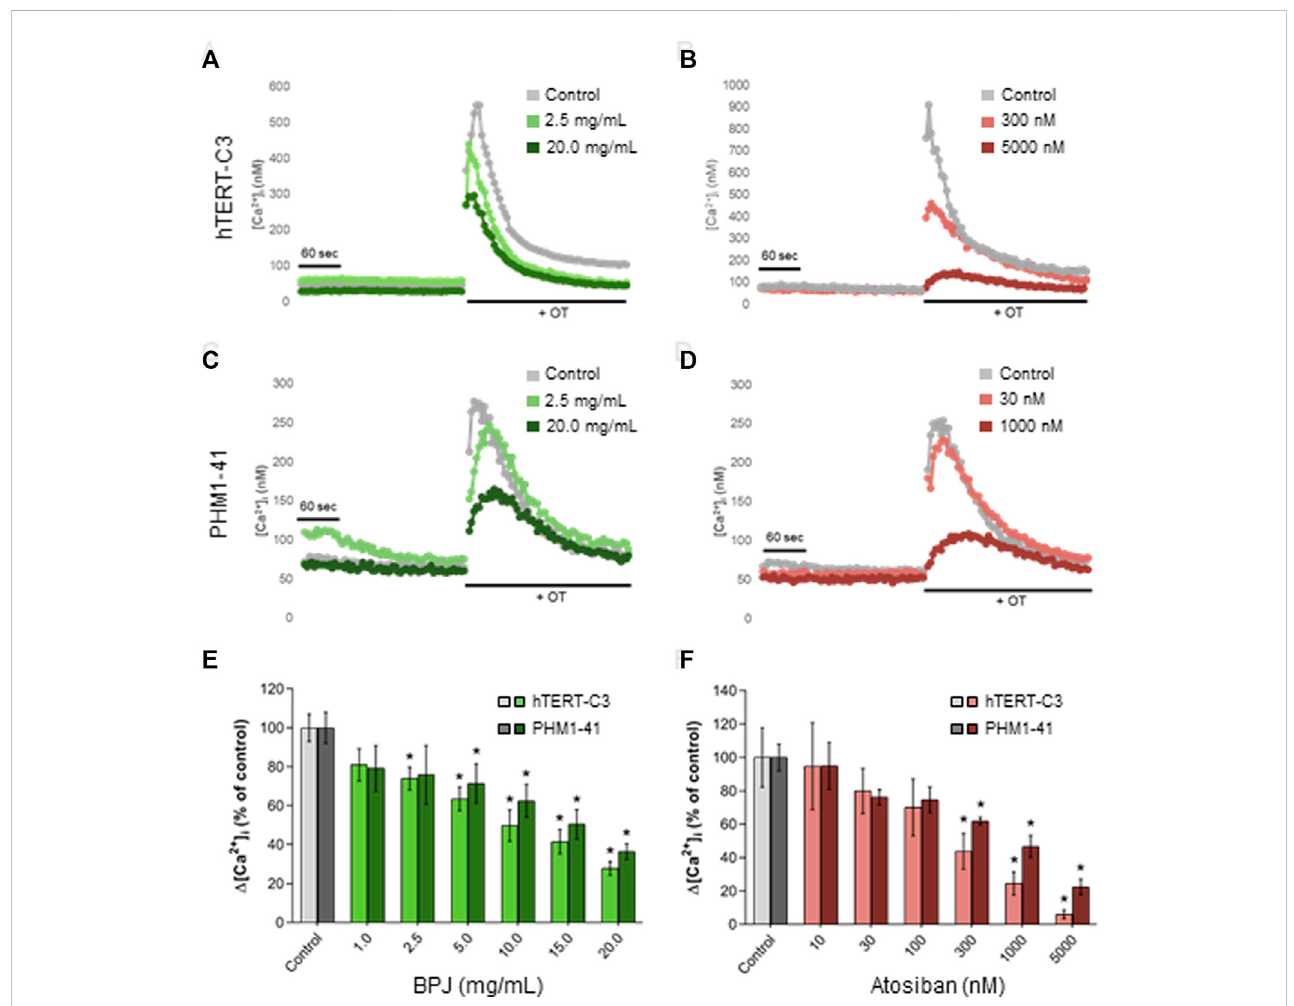
FIGURE 3 ComparisonbetweentheeffectsofBPJandatosibanonOT-inducedriseof[Ca 2+ ] i inmyometrialcelllines.Time-courseofOT-induced[Ca 2+ ] i response in hTERT-C3 (A, B) and PHM1-41 (C, D) cells when pre-incubated in the absence ( a-d , grey lines) or in the presence of BPJ (A, C) or atosiban (B, D) [Ca 2+ ] i was measured for 4 min before stimulation with 100 nM OT. Data shown are from one representative experiment. Concentration-dependent effect of BPJ (E) or atosiban (F) ontheoxytocin-induced[Ca 2+ ] i increaseinhTERT-C3(lightercolor)andPHM1-41(darkercolor)cells.Valuesrepresentthemean±SEMof4 (PHM1-41) or 6 (hTERT-C3) independent experiments performed in quadruplicate and are expressed as percentage of control; * p <